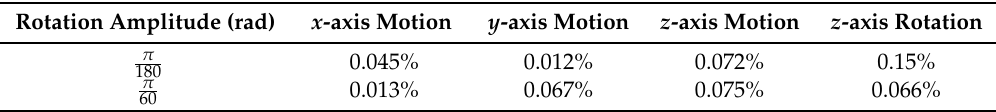
Table 2. Average percentage deviation between the simulation results respectively based on numerical model and mathematical